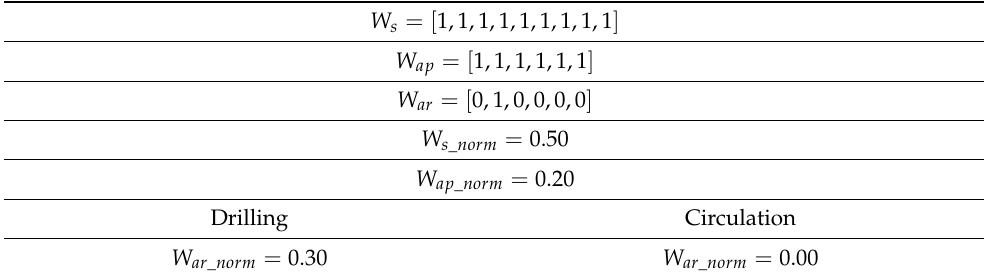
Table 3. Weight assignments for different reward function